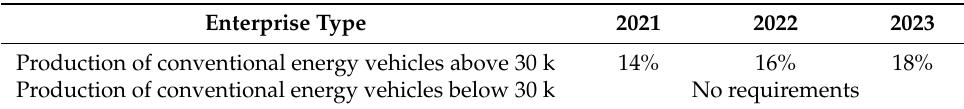
Table 2. Requirements on NEV Credit Ratio